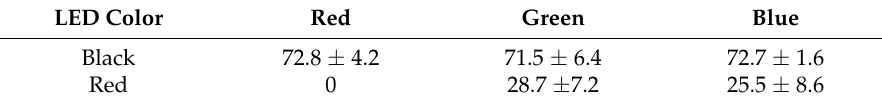
Table 2. Relative contrast reduction (%) in tattoo after laser treatment.